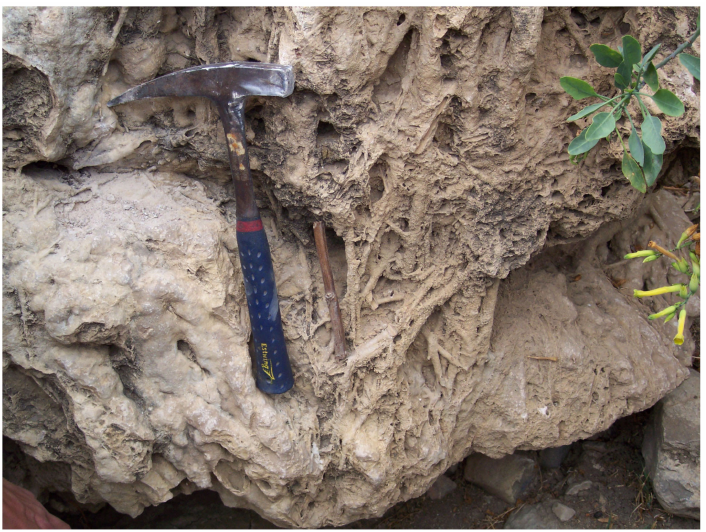
Figure 2. Plant remains encrusted in phytohermal tufa at the Romanatt dam (Tigray, Ethiopia).